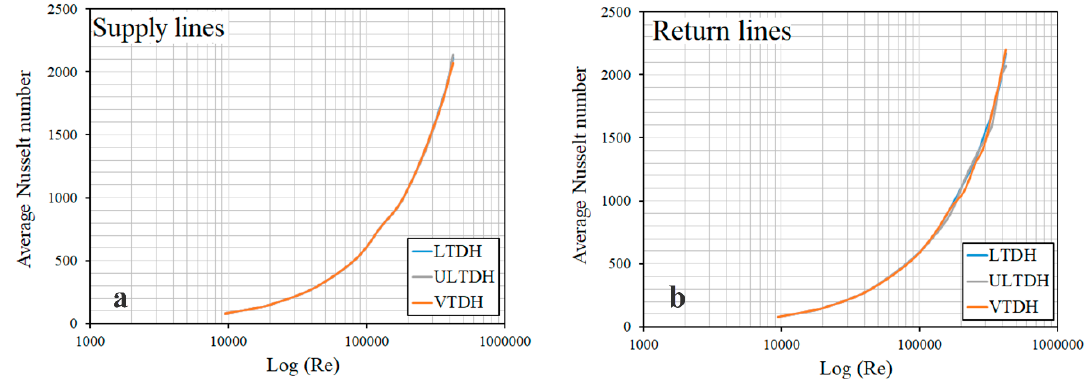
Figure 11. The level of pressure drop through the supply lines in each case.